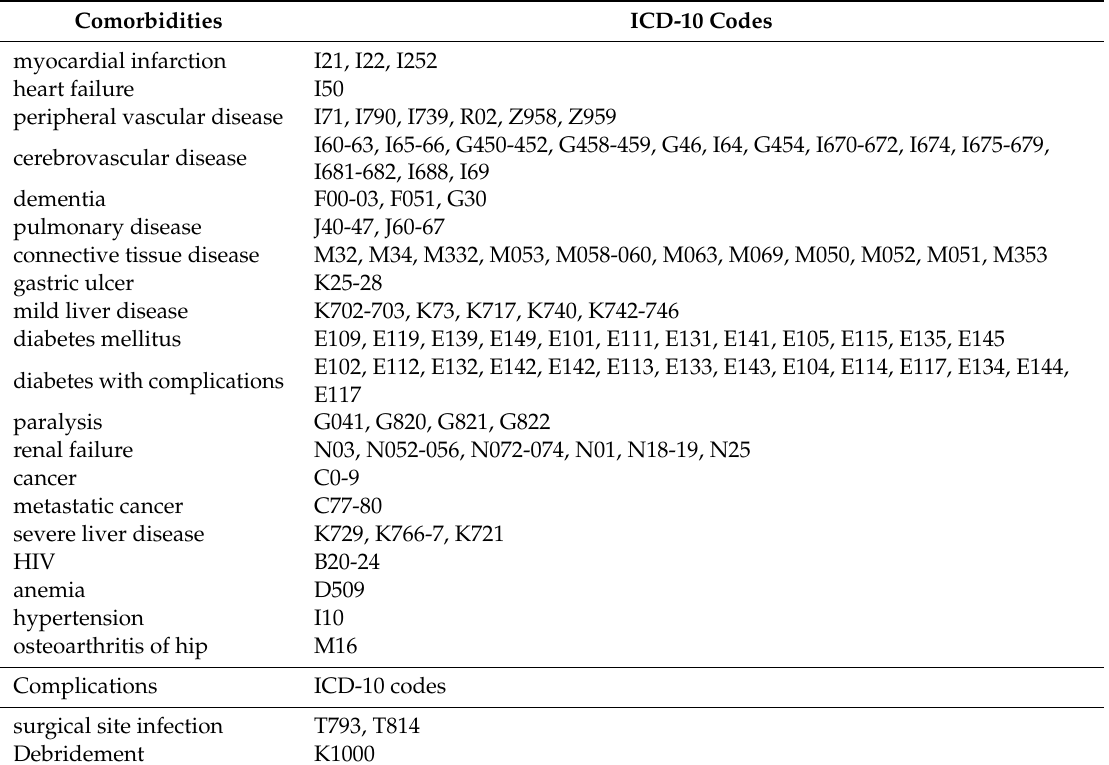
International Classification of Diseases (ICD)-10 definitions for comorbidities and complications.